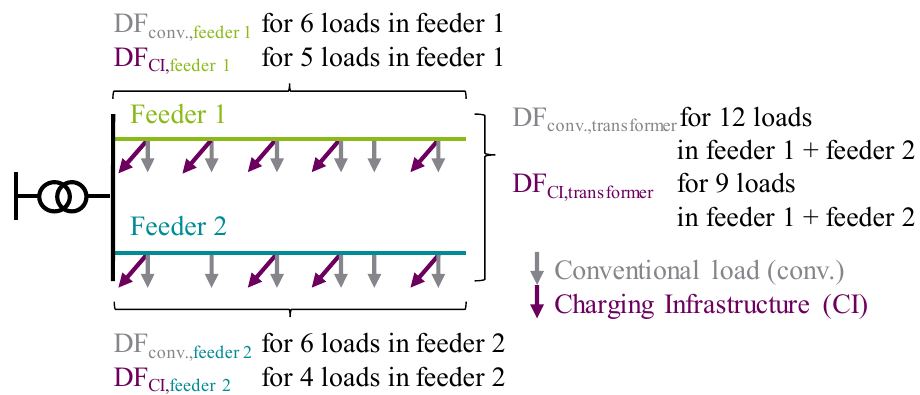
Figure 1. Planning perspectives considering the respective demand factor (DF) [25].